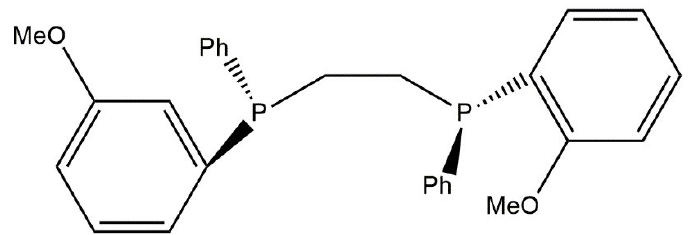
Simplified formula of the chiral form of phosphine-1,2-bis[(2-methoxyphenyl)phenylphosphine] ethane.